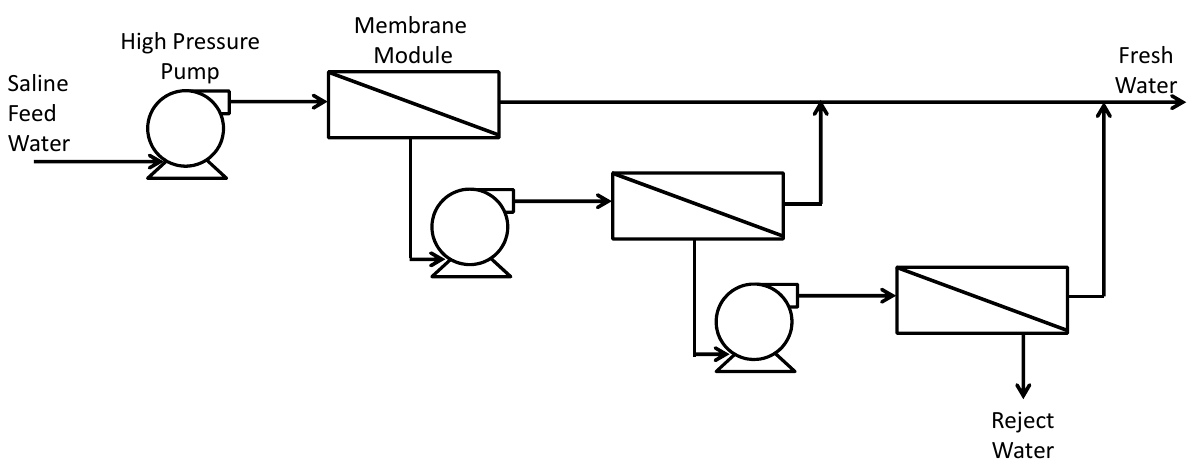
Figure 5. 3-stage system with intermediate pumps.